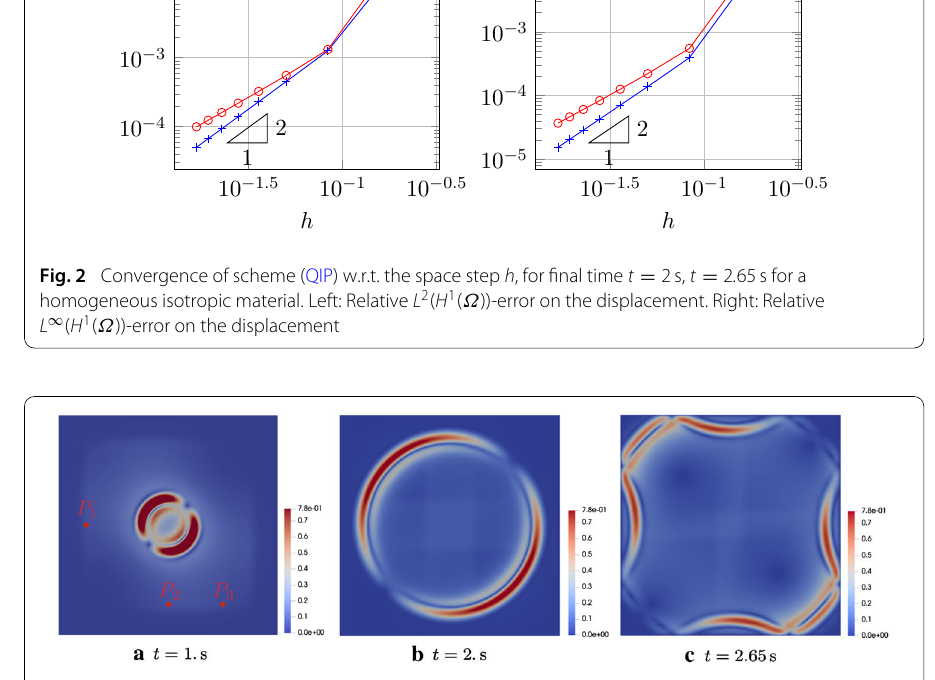
Fig. 3 Elastic wave propagation in a homogeneous isotropic medium (absolute value of the displacement